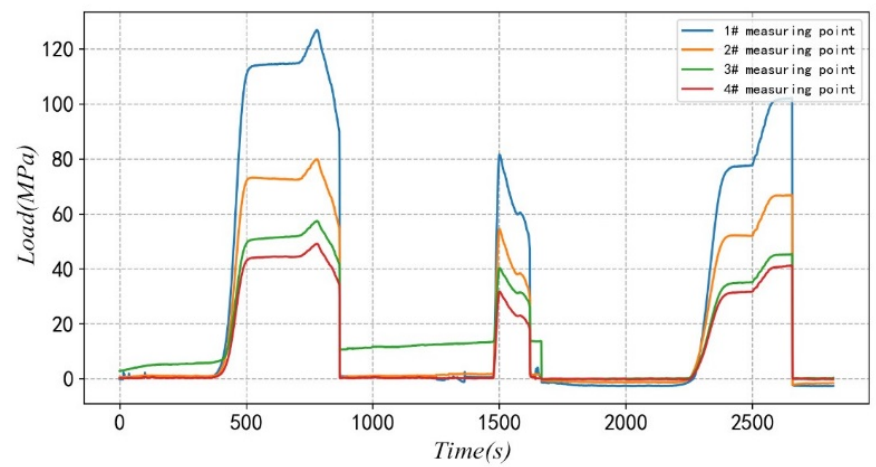
Figure 7. Stress time history of each measuring point.